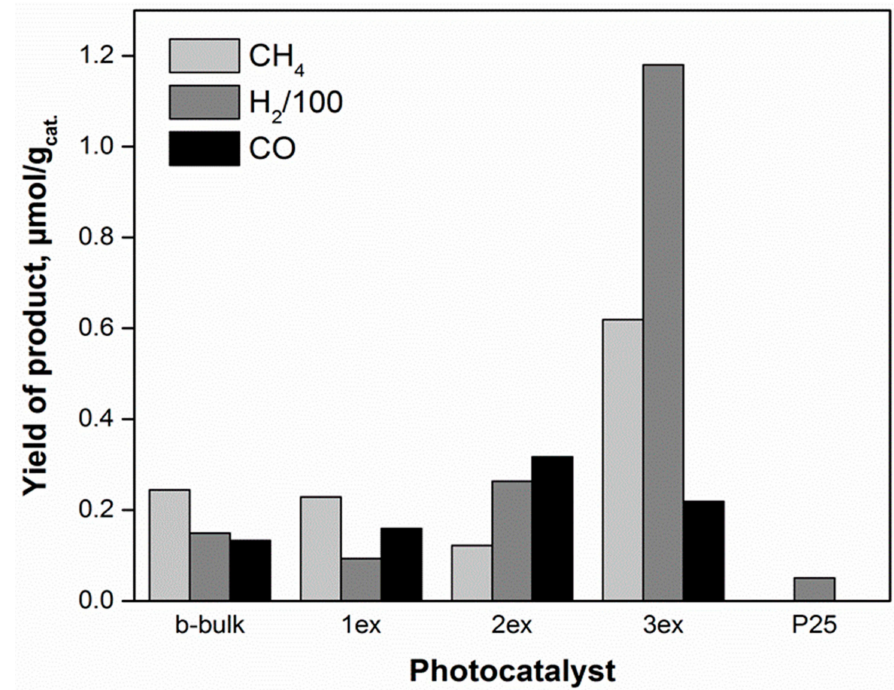
Figure 11. All product yields of CO 2 photocatalytic reduction (after 8 irradiation hours) over the g-C 3 N 4 (bulk and 1ex, 2ex and 3ex) and P25